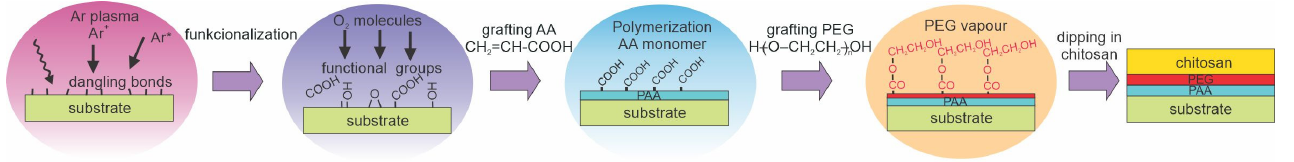
Figure 10. A method for immobilizing a thin chitosan film using the following steps: formation of dangling bonds by Ar plasma, interaction of dangling bonds with oxygen, plasma polymerization of a layer resembling cross-linked polyacrylic acid (PLA), exposure to polyethylene glycol (PEG) vapors, and dipping in chitosan solution.